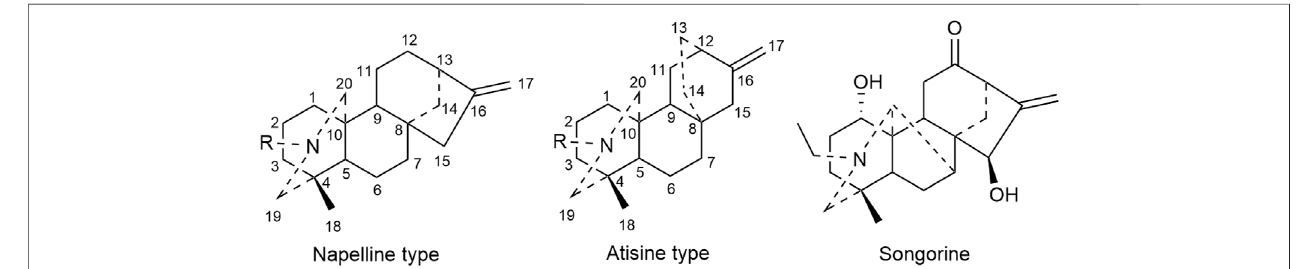
FIGURE 3 | Structures of songorine and C 20 diterpenoid alkaloids in Fuzi.